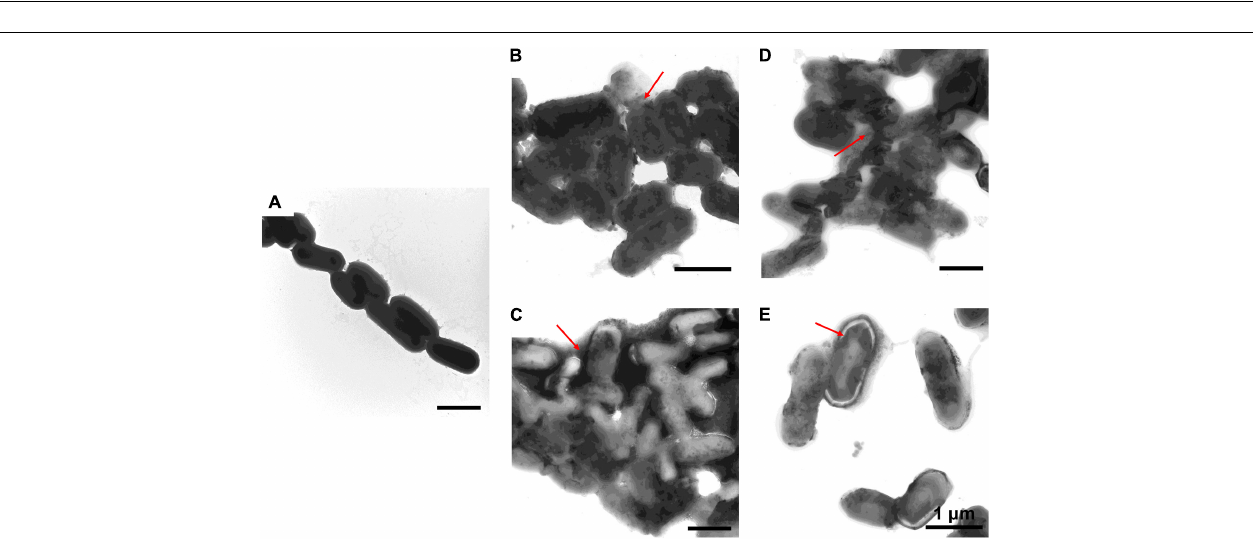
FIGURE 6 | Transmission electron microscopic observation of L. monocytogenes . L. monocytogenes incubated with PBS (A) or with 1–6, P-6, S-6, and L-6 (B–E) at 28 ◦ C for 30 min. The red arrow points to where the cell membrane has broken and the cell contents have flowed out.